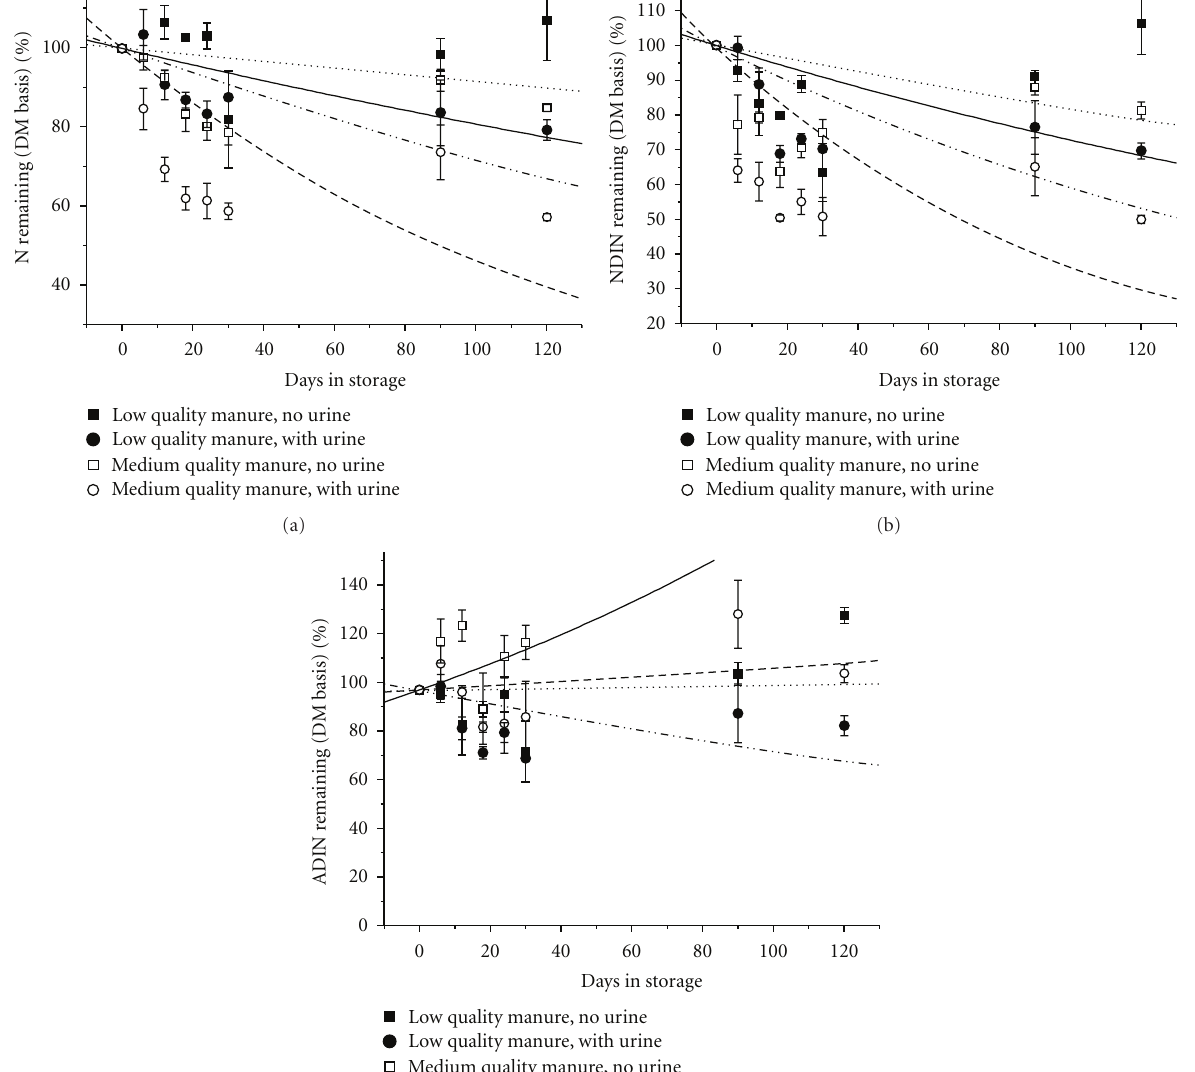
urine treatments ( α =